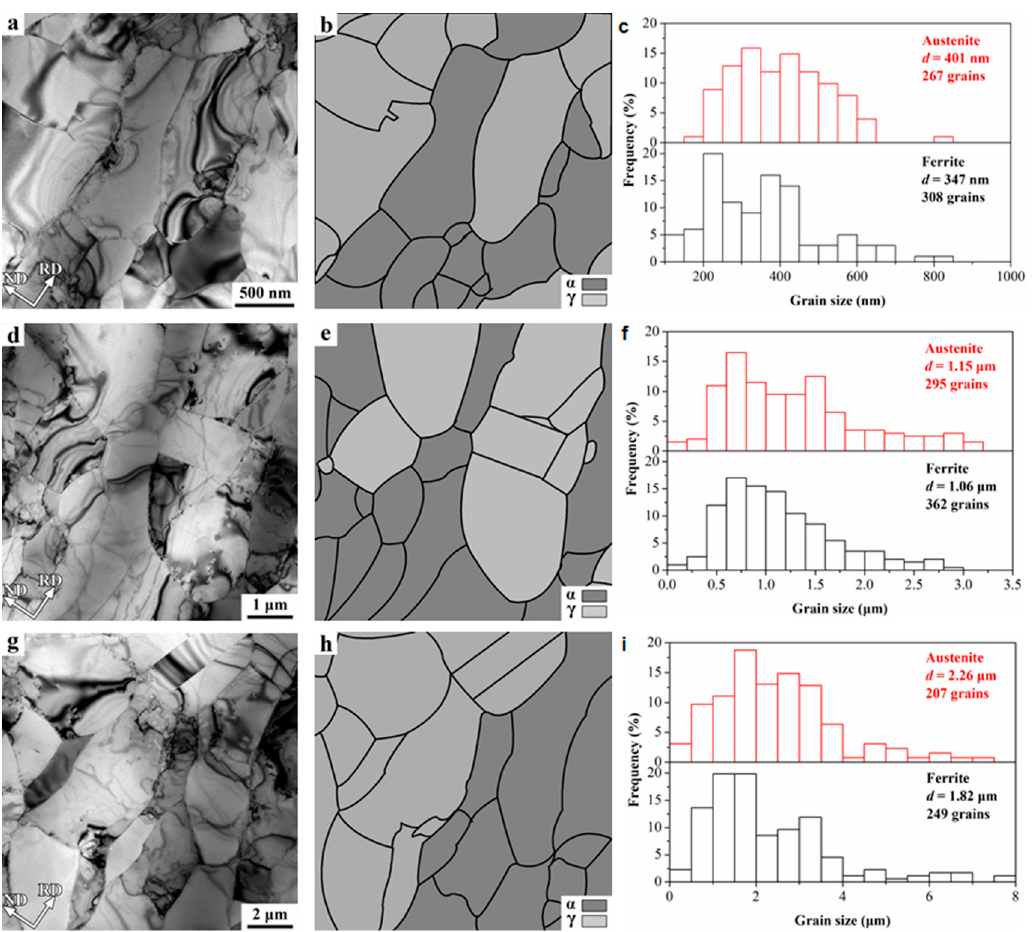
Figure 3. Microstructural characterizations of annealed samples: ( a – c ) Representative TEM image, the corresponding boundary sketch, and the grain size distribution of the sample annealed at 700 °C for 30 min, respectively; ( d – f ) Representative TEM image, the corresponding boundary sketch, and the grain size distribution of the sample annealed at 900 °C for 30 min, respectively; ( g – i ) Representative TEM image, the corresponding boundary sketch, and the grain size distribution of the sample annealed at 1000 °C for 30 min, respectively. Table 1. Structural parameters of samples cold-rolled and annealed.